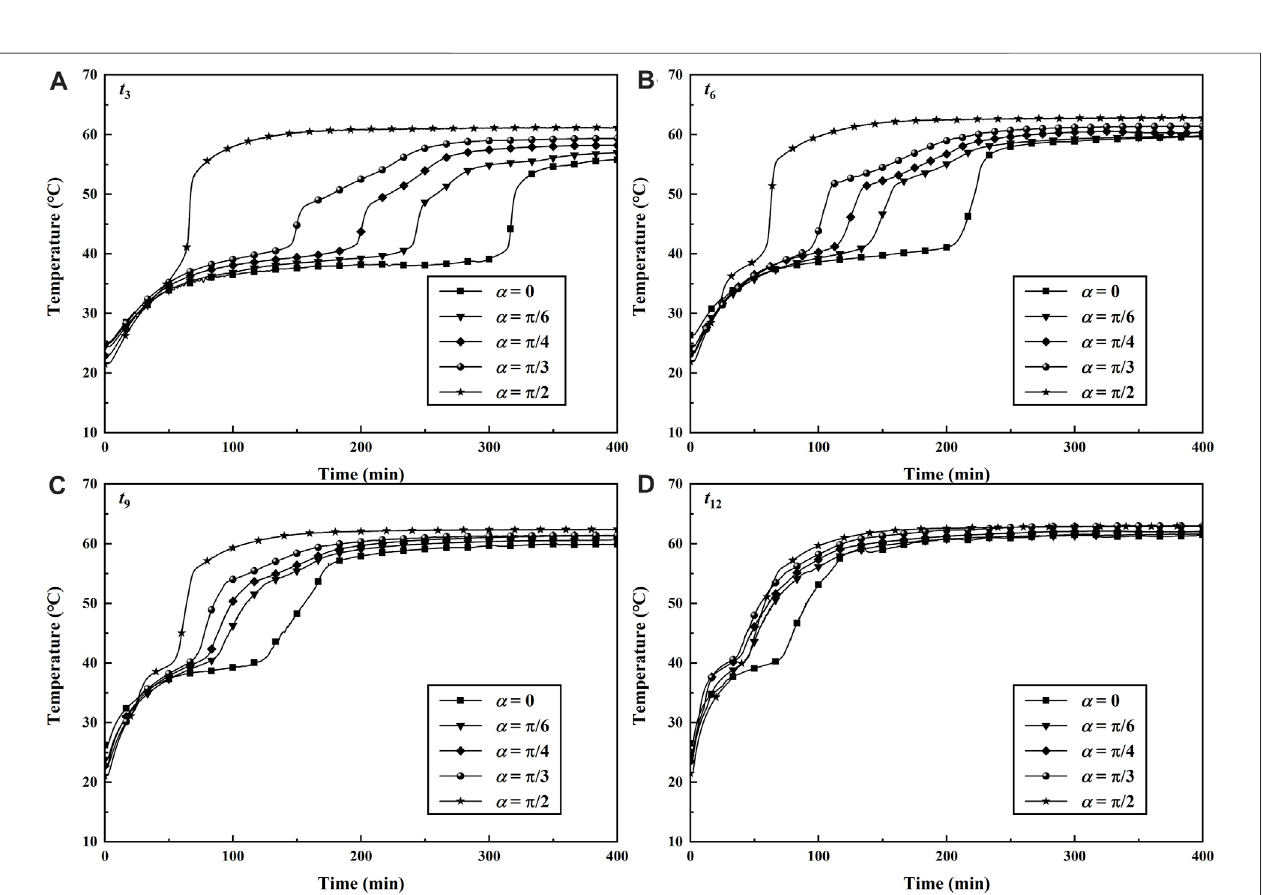
FIGURE 9 | Transient temperatures with different inclined angles during the melting process for t in = 63.1 ° C, q v = 40 L/h.